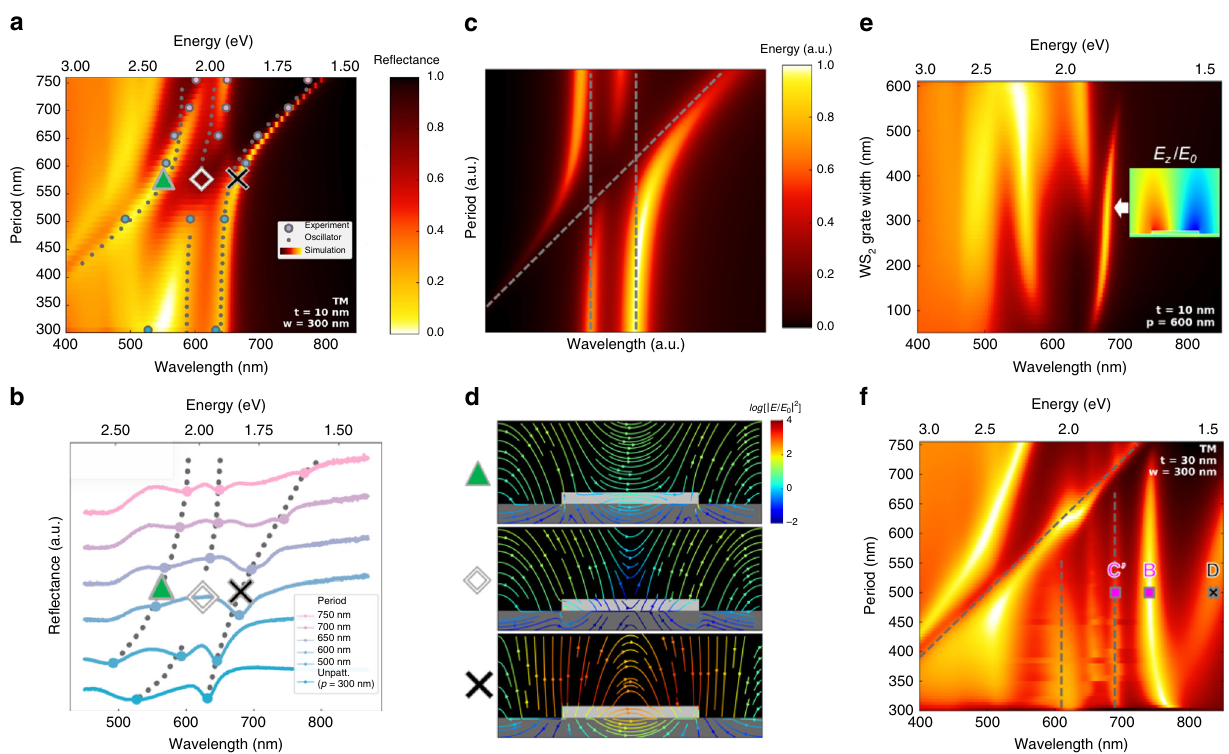
Fig. 5 Strong three-oscillator coupling below critical thickness. a Period dependence of simulated TM re fl ectance spectra. Thickness and width are fi xed at 10 nm and 300 nm, respectively. Period is swept from the unpatterned case ( w = p = 300 nm) to a period of 750 nm. The dashed lines represent the calculated absorption spectra based on the three-oscillator model in ( c ), while the circles represent experimentally measured peak positions from ( b ). b Experimental re fl ectance spectra of the WS 2 grating structure with a fi xed thickness of 10 nm and a width of 300 nm. Spectra for the patterned case, p = 500 nm, 600 nm, 650 nm, 700 nm, and 750 nm are plotted and offset for clarity. The marked peaks are also plotted in ( a ), for comparison with simulation. c The calculated energy dispersion relation based on the three-oscillator model. The three oscillators represent the grating mode, LEP mode, and UEP mode. The bare modes are represented by dashed lines in the fi gure. By fi tting the oscillator model to the simulation and experiment data, we obtain an effective mode separation energy of 410 meV. d Comparison of the fi eld-line pro fi les of the UP, MP cut-off, and LP regions marked with triangles, diamonds and crosses, respectively in ( a , b ). At the point marked with a diamond, almost all the electric fi eld lines are repelled out of the resonator rendering the highly lossy WS 2 resonator invisible in the far- fi eld. e Simulated re fl ectance spectra of grating resonators showing the evolution of the strong-coupling- induced separation as a function of width in the wavelength range of ~550 – 650 nm. Inset: the E Z fi eld pro fi le of the plasmonic mode for t = 10 nm. f Period dependence of re fl ectance of the WS 2 grating structure for t = 30 nm and w = 300 nm. The three dashed lines representing the bare modes are also shown in the fi gure, indicating the exciton mode at λ = 610 nm almost vanishes. The dielectric grating induced mode is unable to couple with the pure exciton without the exciton being hybridized with the cavity